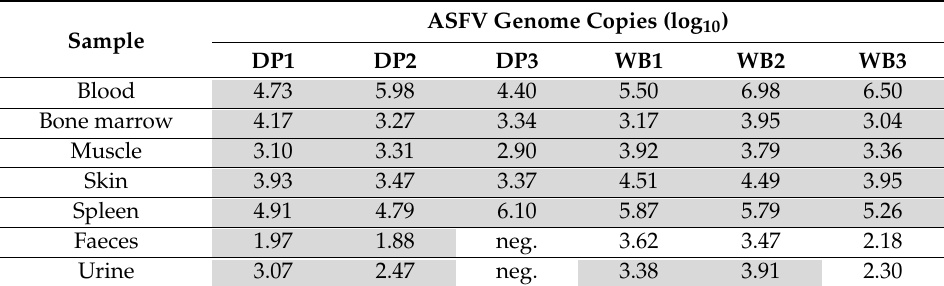
Table 2. PCR and HAT results of blood, tissues and excretions on day 0. Samples highlighted in grey were also positive for infectious virus. Samples of DP1 and WB1 were stored at − 20 ◦ C, of DP2 and WB2 at 4 ◦ C and of DP3 and WB3 at room